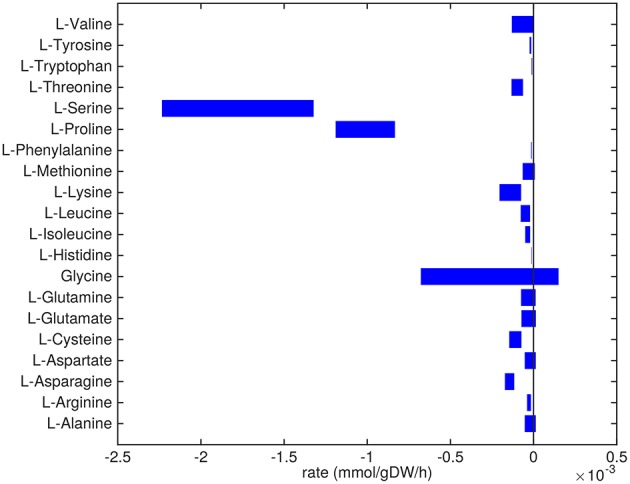
Predicted amino acids uptake and secretion rates by Mtb in the host. Predicted ranges of uptake and secretion rates (mmol gDW−1 h−1) of amino acids by Mtb inside the host are indicated by blue bars. Negative values denote uptake and positive values denote secretion.